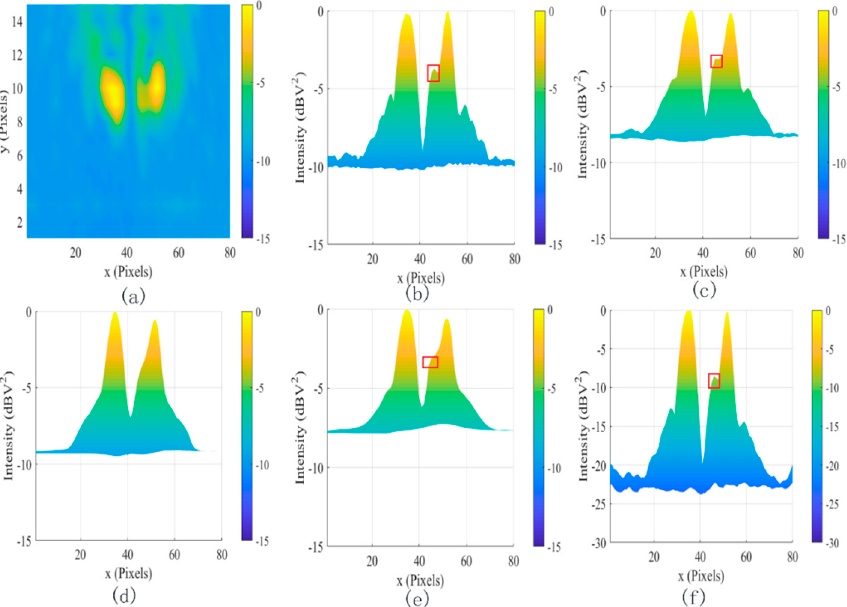
Figure 10. Settings of the experiment. ( a ) Reflective surface and ( b ) horn antennas.